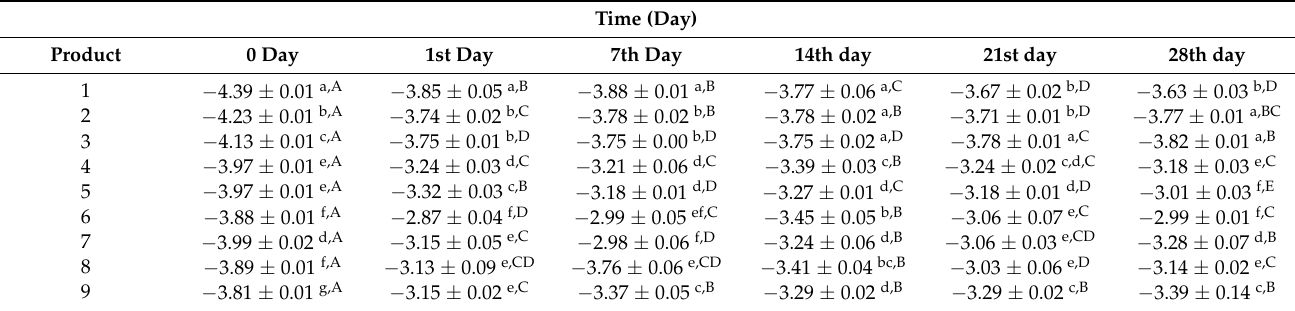
Table 5. Effect of addition of FM, GA and yogurt culture and B. lactis at different concentration on color a* value in kefir samples during storage time.